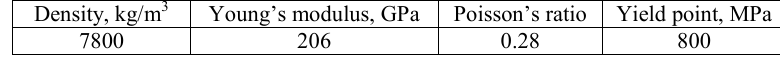
Table 1. Physical-mechanical properties of steel.